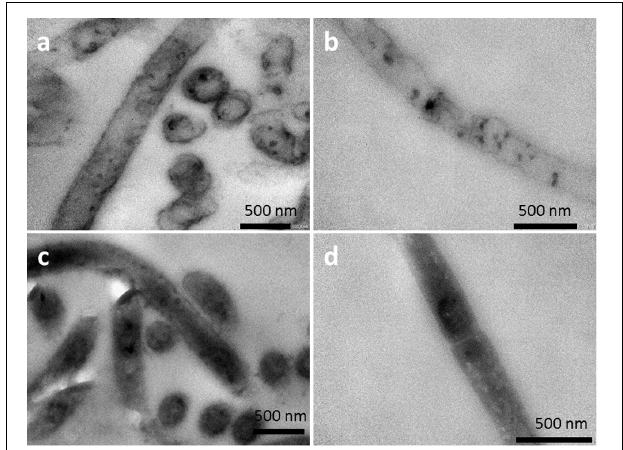
FIGURE 5 | TEM images of DAB-stained cells (a,b) cultivated under anodic EET conditions. Image (a,b) was obtained in the presence and absence of H 2 O 2 , respectively. As a comparison to electrochemical cultivation, TEM images of DAB-stained cells cultivated anaerobically in a conical flask with LB were shown in (c) and (d) . Image (c) and (d) was obtained in the presence and absence of H 2 O 2 ,